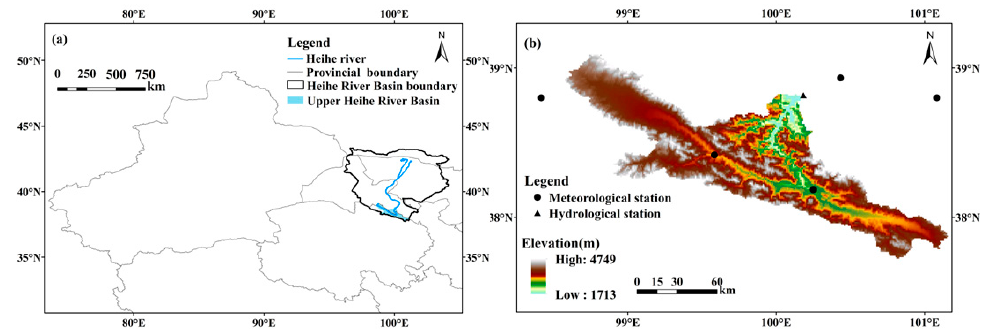
Figure 1. ( a ) Geographical location of the HRB and its headwaters. ( b ) Locations of meteorological and hydrologic stations in the HRB headwaters as seen on a Digital Elevation Model (DEM).